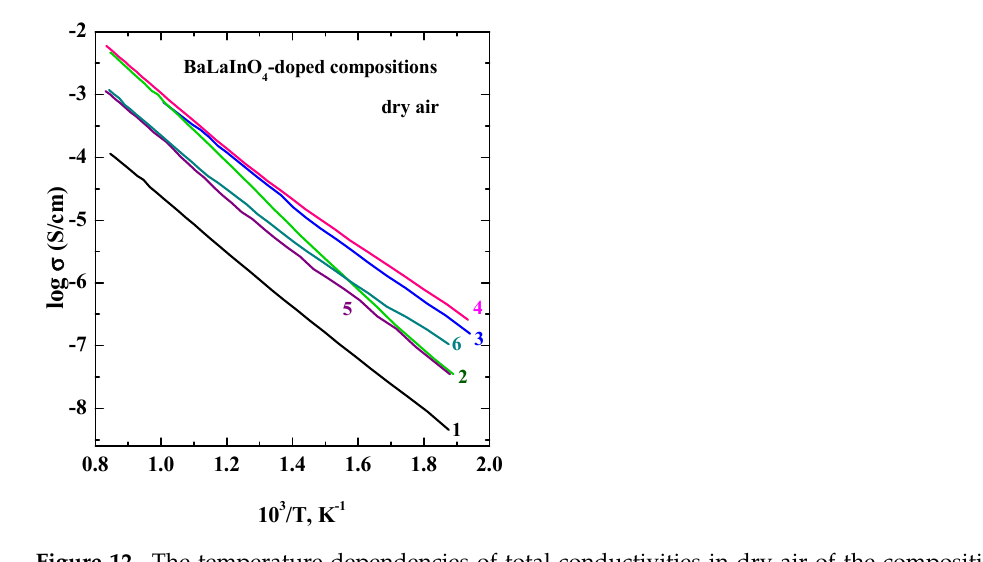
Figure 12. The temperature dependencies of total conductivities in dry air of the compositions BaLaInO 4 (1) [74], BaLa 0.9 Ca 0.1 InO 3.95 (2) [74], BaLa 0.9 Sr 0.1 InO 3.95 (3) [74], Ba 1.1 La 0.9 InO 3.95 (4) [74], BaLaIn 0.9 Ti 0.1 O 4.05 (5) [81], BaLaIn 0.9 Nb 0.1 O 4.10 (6) [84]. The solid solution Ba 1+ x La 1– x InO 4–0.5 x (0 ≤ x ≤ 0.15) was investigated in [79] and